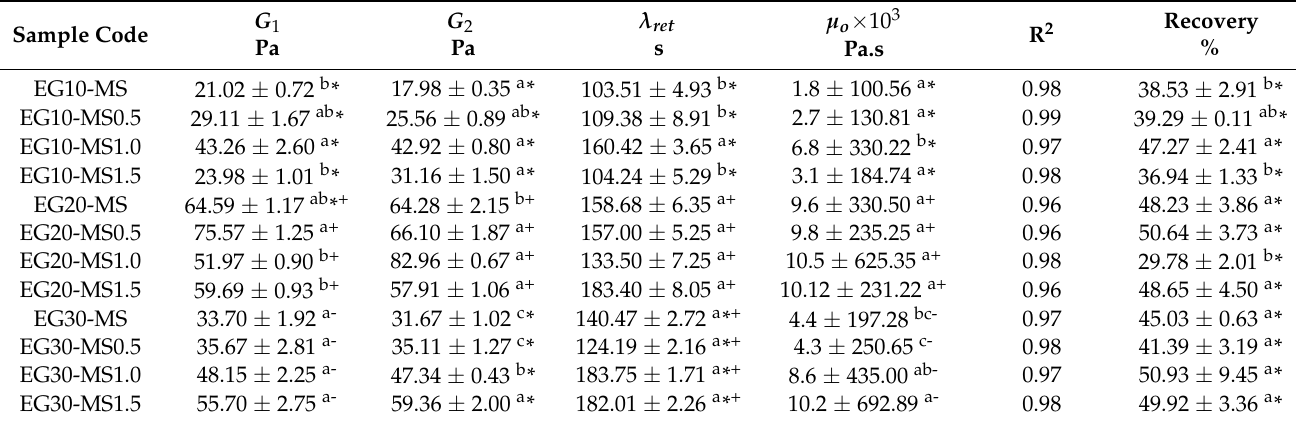
Table 4. Burgers model parameters obtained from carboxymethyl cellulose/mango-starch emulsion gels with 1% w/w of mango peel